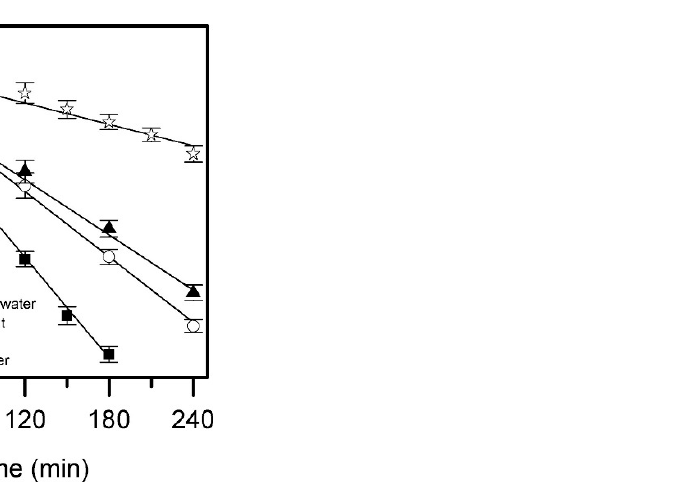
Figure 3. Evolution of SMX upon CWPO with magnetite in different real aqueous matrices ([SMX] 0 = 5 mg L − 1 ; [H 2 O 2 ] 0 = 25 mg L − 1 ; [magnetite] 0 = 1 g L − 1 ; pH 0 = 5; T = 25 °C). Experimental (symbols) and model fit (solid lines). Reprinted with permission from ref. [47]. Copyright 2018 Elsevier.